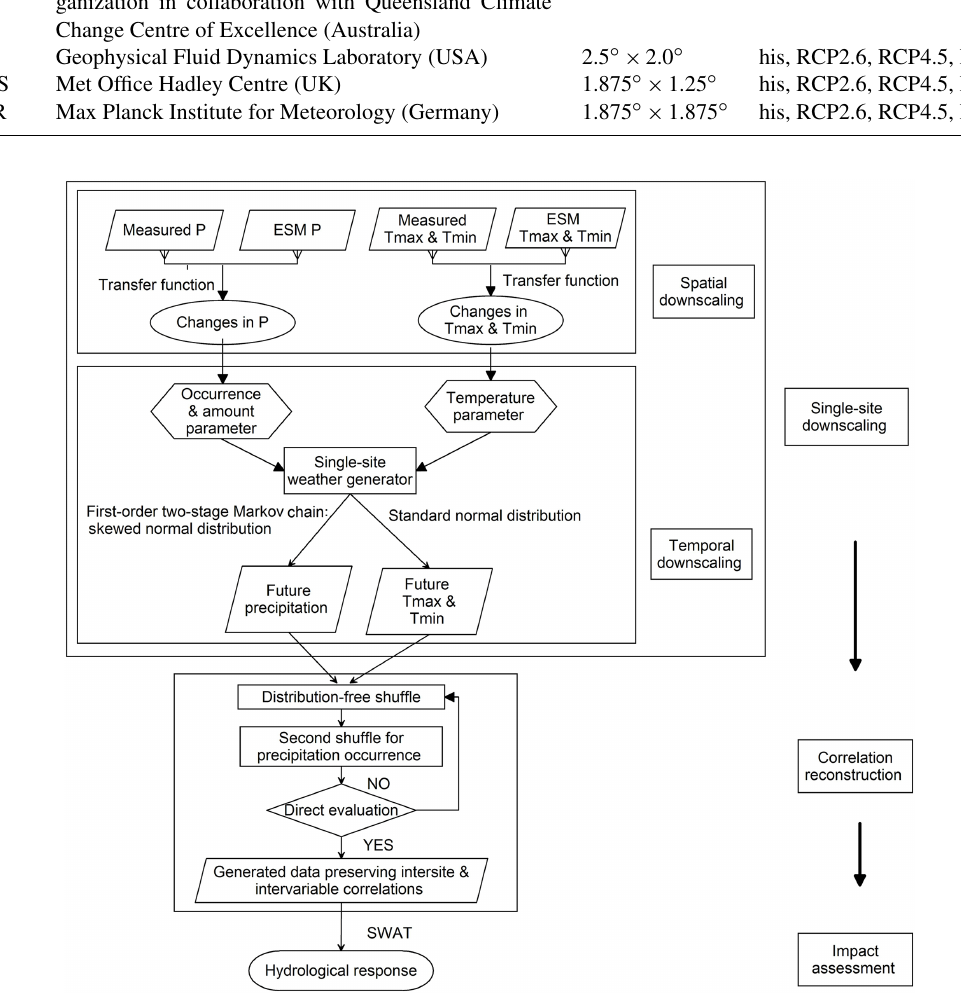
Figure 2. Schematic of the multisite multivariate GCM downscaling and the structure of this study.